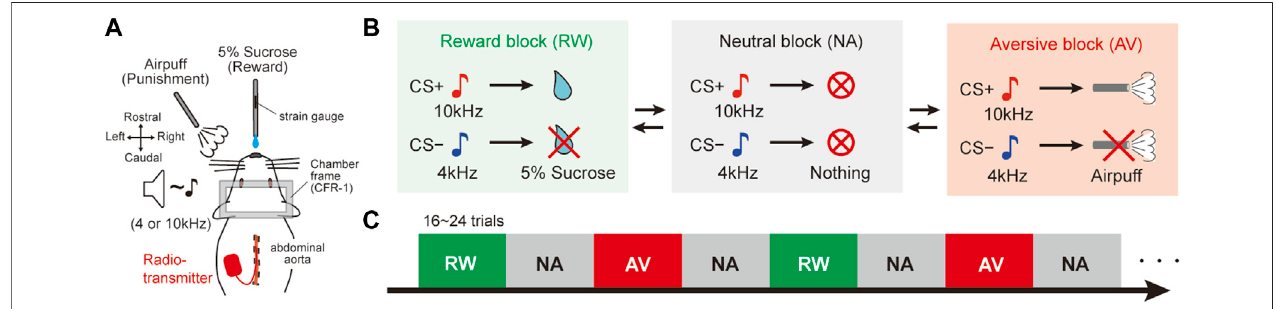
FIGURE1| Dynamicallychangingclassicalconditioningtaskwithemotional valence. (A) Schematicdiagram ofthebehavioral task.Stainless tubes forreward and air-puffdeliverywereplacedinfrontofthefaceofhead- fi xedrats.Aradiotransmitterwasimplantedintotheabdominalaortatorecordthebloodpressurebytelemetry.A strain gauge was attached to the reward tube to monitor the amplitude of licking movements. (B) Pavlovian procedure with three distinct context blocks. In the reward (RW) block, atone cue (CS+, 10 kHz) preceded the reward (US+, 5%sucrose), and another tone (CS − , 4 kHz) wasnot followed bya reward (US − ).In the aversive (AV) blocks, CS + preceded an air puff (US+) and no air puff (US − ) followed CS − . Both CS tones preceded nothing in the neutral (NA) blocks. CS, conditioned stimulus; US, unconditioned stimulus. (C) Trial sequence of the behavioral task. NA blocks were alternately deployed between RW and AV blocks. There were 16 – 24 trials per block. The order of the blocks was fi xed, but they randomly started with RW or AV every experimental day. There was no cue indicating the block switch.